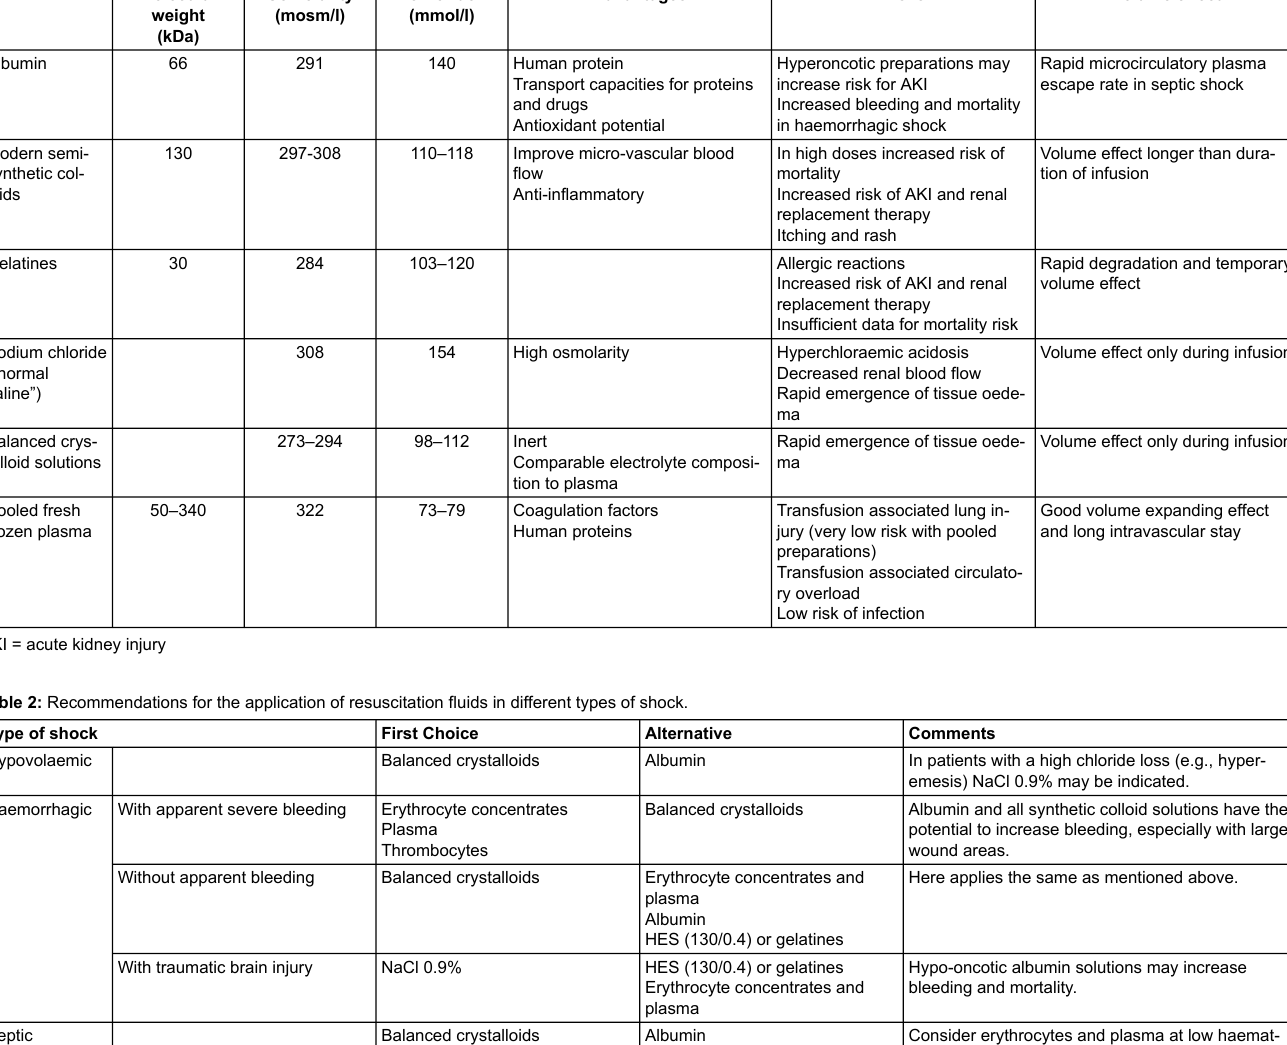
Table 1: Advantages and risks of preparations for volume resuscitation in septic and haemorrhagic shock. Molecular weight